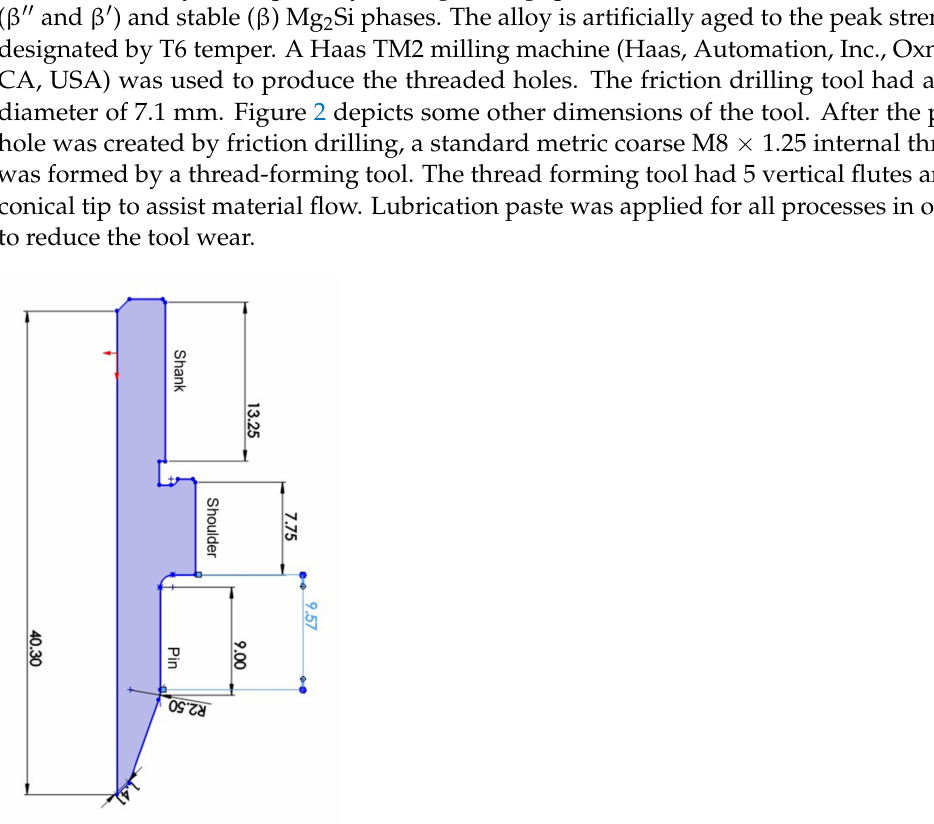
Figure 2. Profile dimensions of the friction drilling tool. The solid shape is described by revolving around the vertical